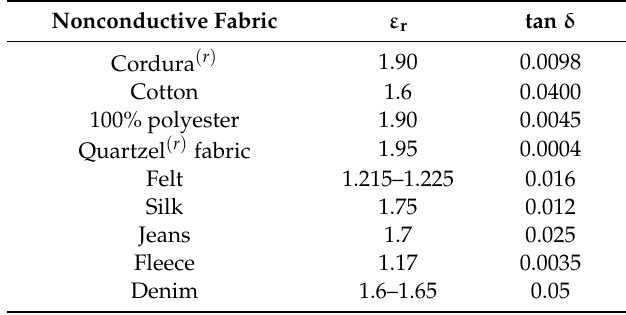
Table 5. Dielectric properties of normal fabrics. Data from reference